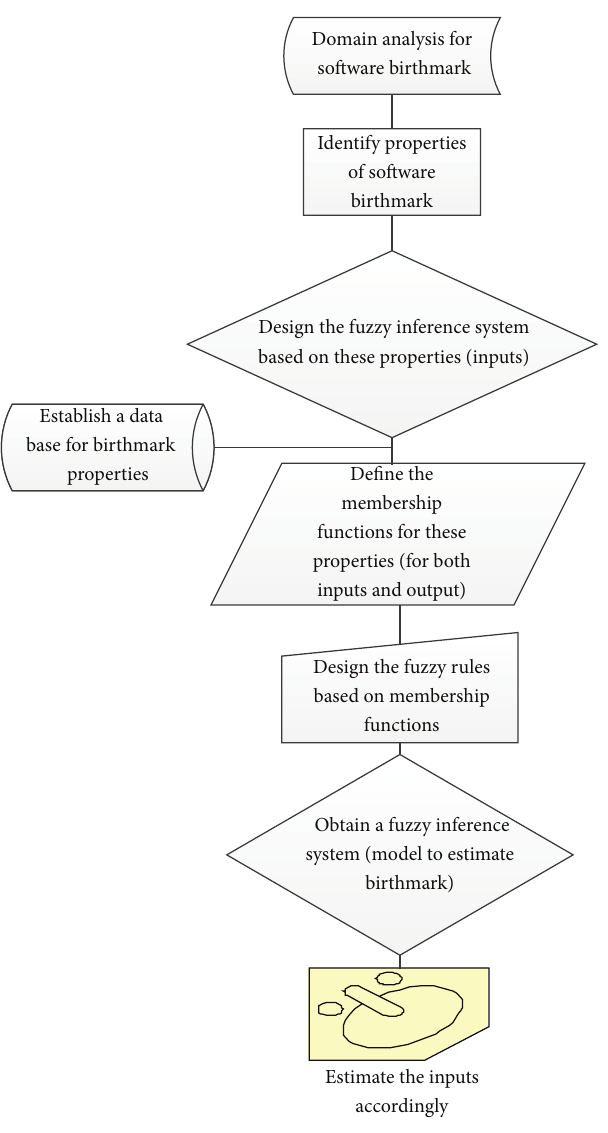
Figure 3: Graphical representation of the proposed algorithm.